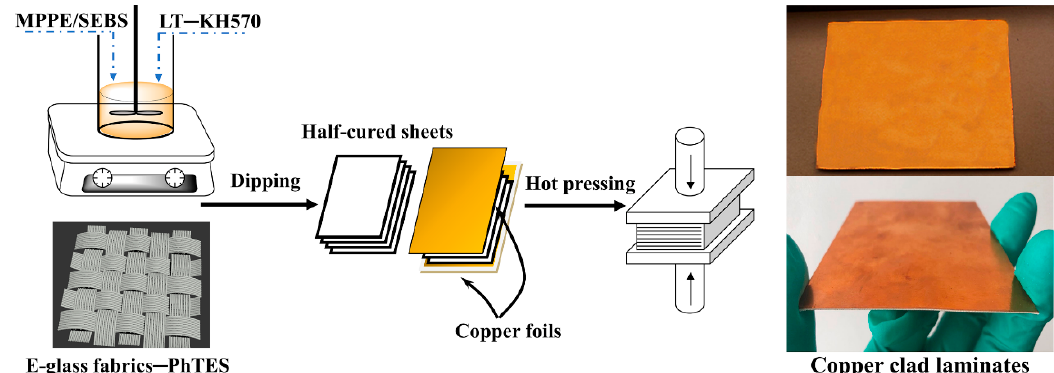
Figure 2. Technological process of copper clad laminates (CCLs) and the real products of CCLs-based MPPE. The CCLs were prepared with four layers of 2116 E-glass fabrics between two layers of 35 µ m copper foils via hot pressing.